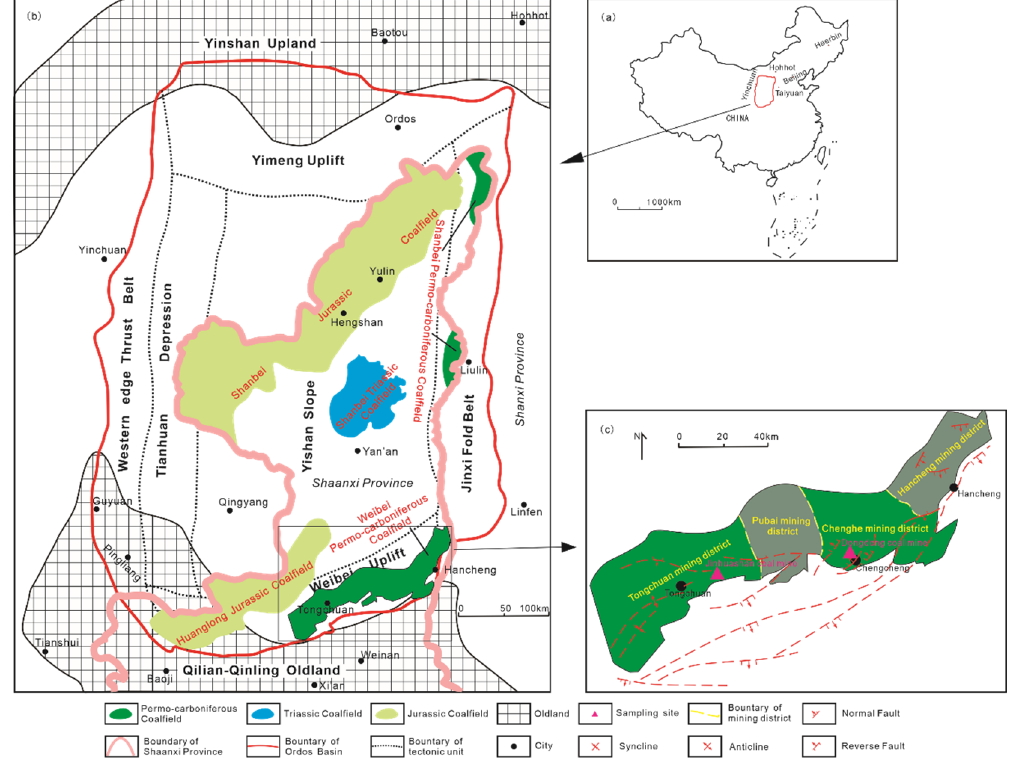
Figure 1. Geological location of the Weibei Coalfield, southeastern Ordos Basin ( a , b ) and distributions of different mining districts and sampling sites ( c ).